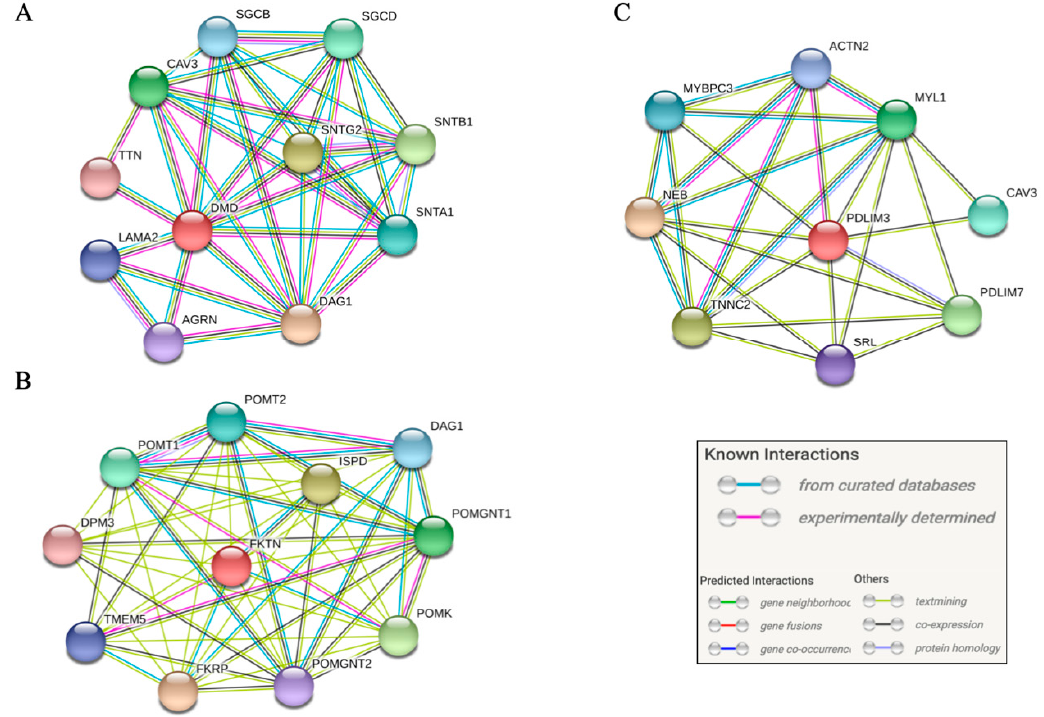
Figure2. Protein-proteininteractionswithhighconfidencescore(confidencescore > 0.7). ( A )interactions Figure 2. Protein-protein interactions with high confidence score (confidence score >0.7). (A) of the product of DMD , ( B ) interactions of the product of FKTN , and ( C ) interactions of the product of interactions of the product of DMD , (B) interactions of the product of FKTN, and (C) interactions of PDLIM3 the product of PDLIM3 .